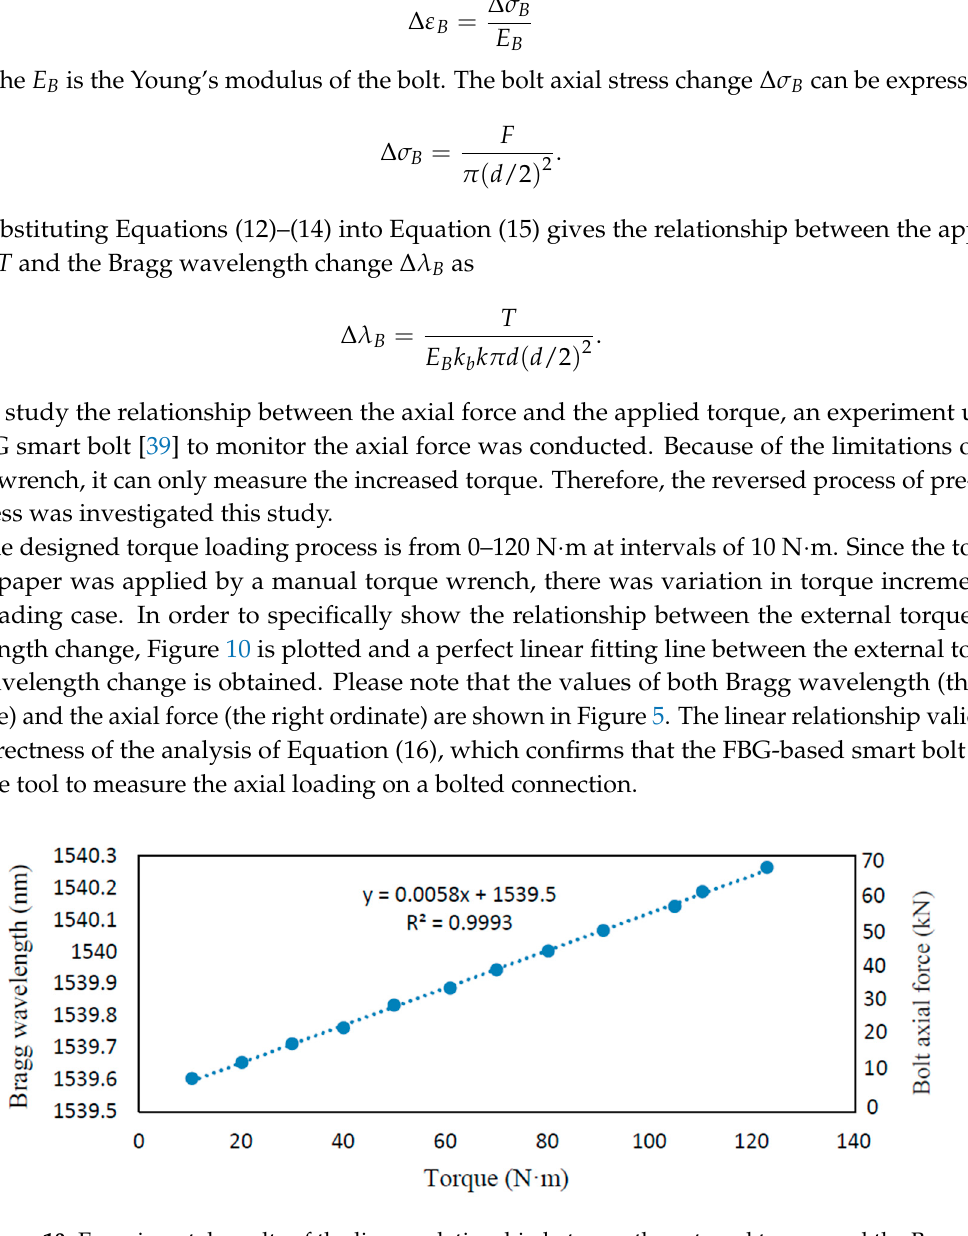
Figure 10. Experimental results of the linear relationship between the external torque and the Bragg wavelength changes.